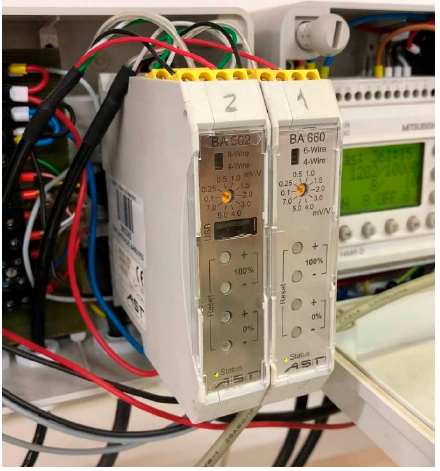
Figure 15. AST signal amplifier for load cells.